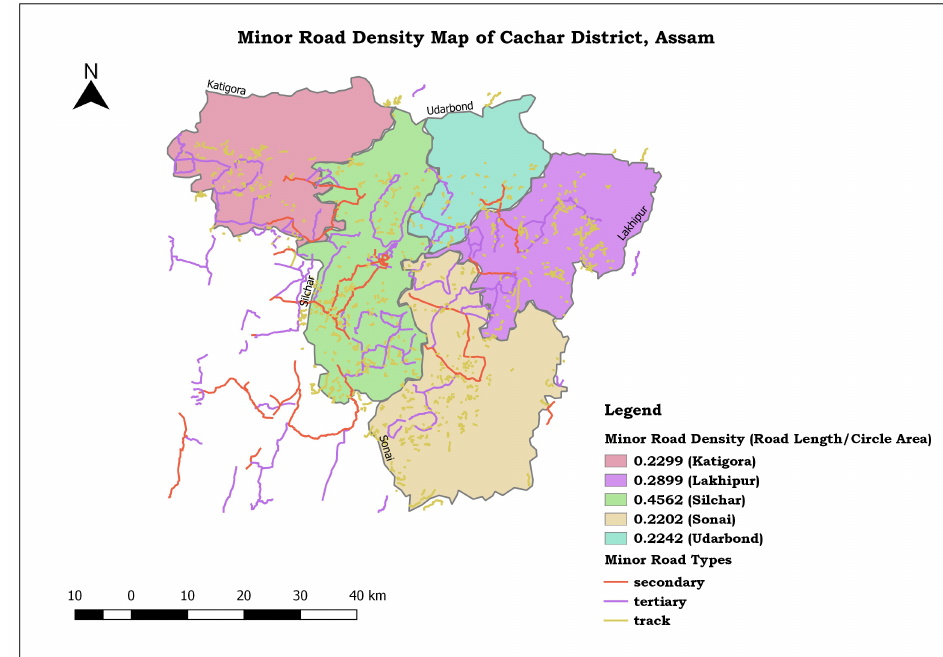
Figure 7. Minor road density